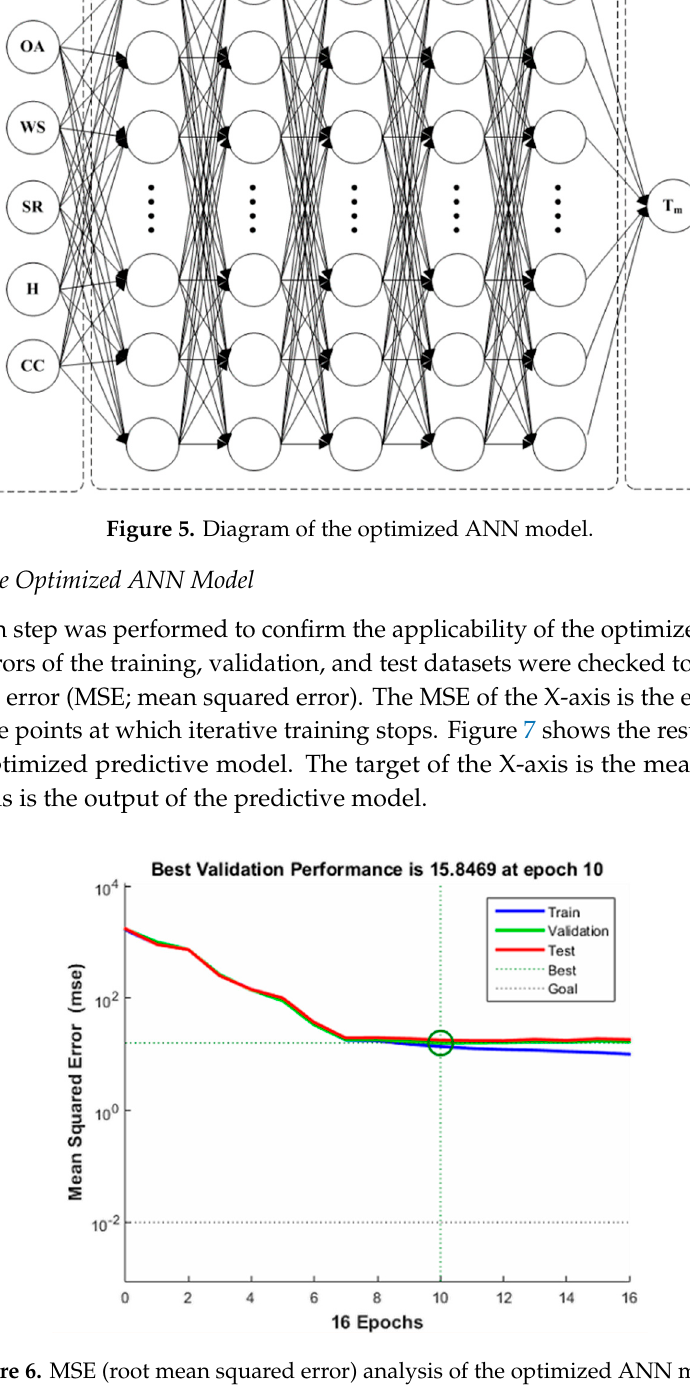
Figure 6. MSE (root mean squared error) analysis of the optimized ANN model.